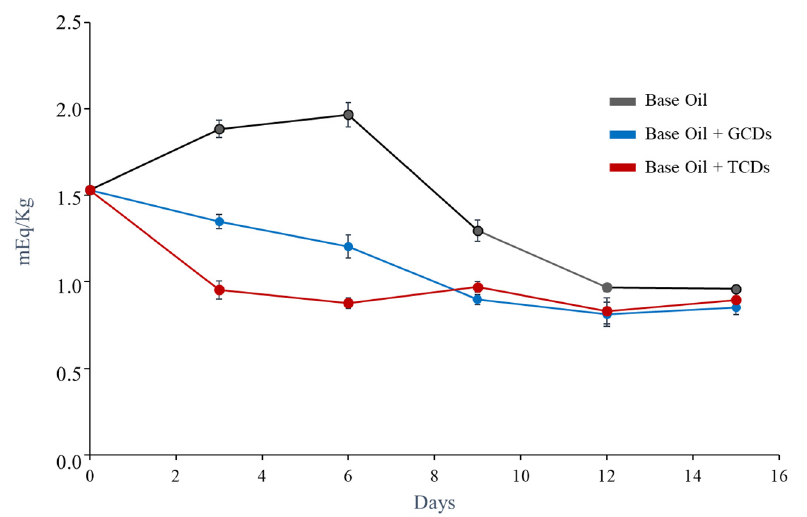
Figure 8. Study of the aging of lubricating oil samples with and without CDs additives.